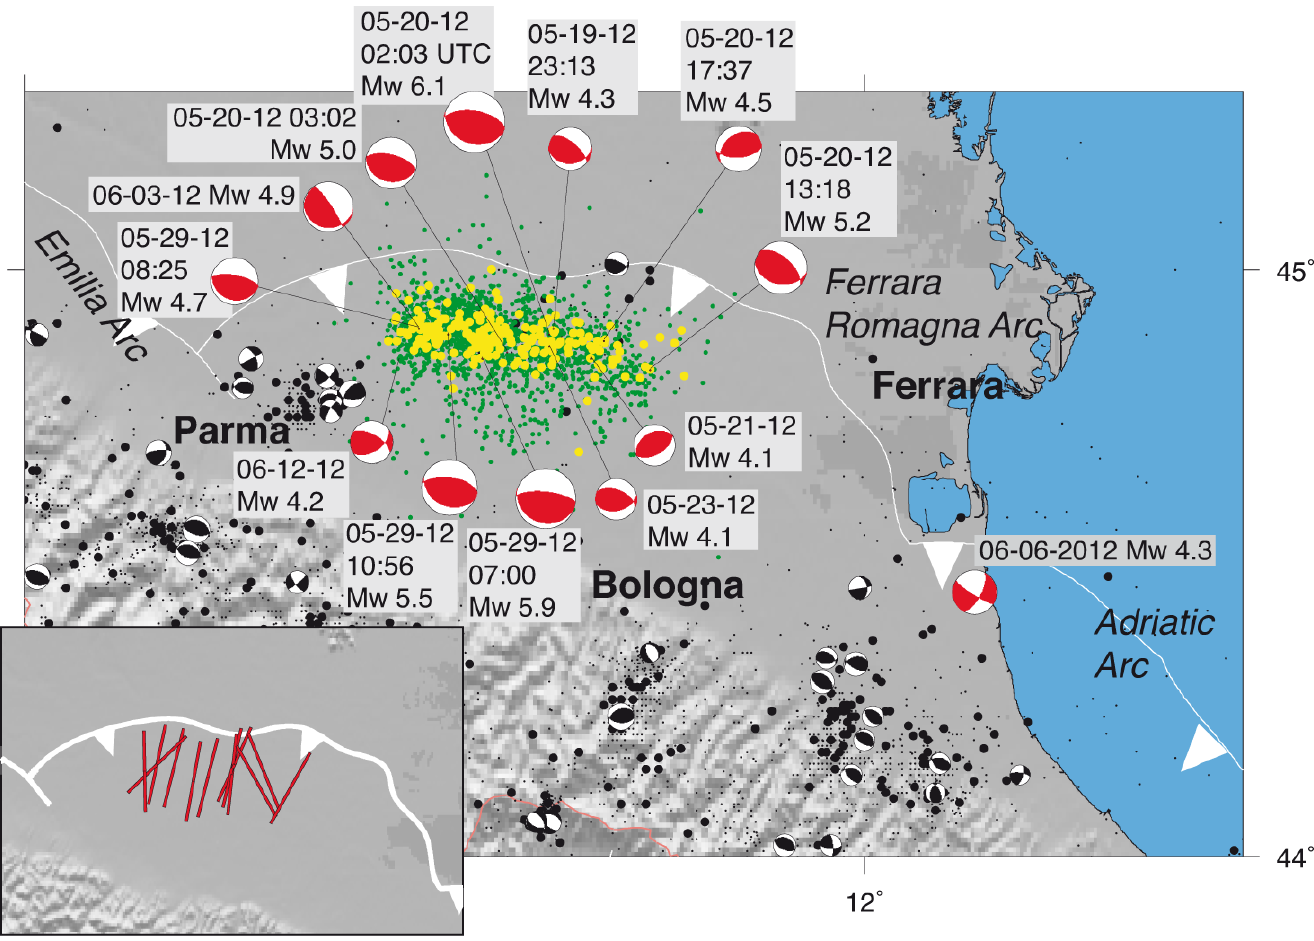
Figure 1. Map showing the QRCMTs (red, focal mechanisms) and their P axes (inset, lower left). Green, seismicity of seismic sequence with a M <3.0; yellow, seismicity of seismic sequence with M ≥ 3.0. The small black focal mechanisms are all RCMTs from the European Mediterranean catalog for seis- micity before May 2012. Black dots (with dimensions proportional to magnitude), previous seismicity from http://iside.rm.ingv.it.